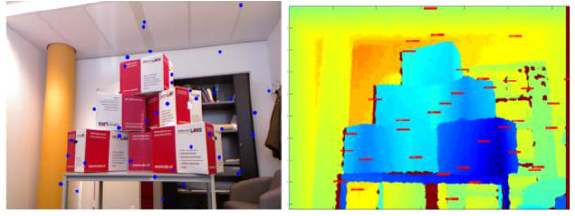
Figure 1. Finding 3D points in the depth image (right) corresponding to 2D keypoints in the colour image (left) by searching along epipolar lines (red